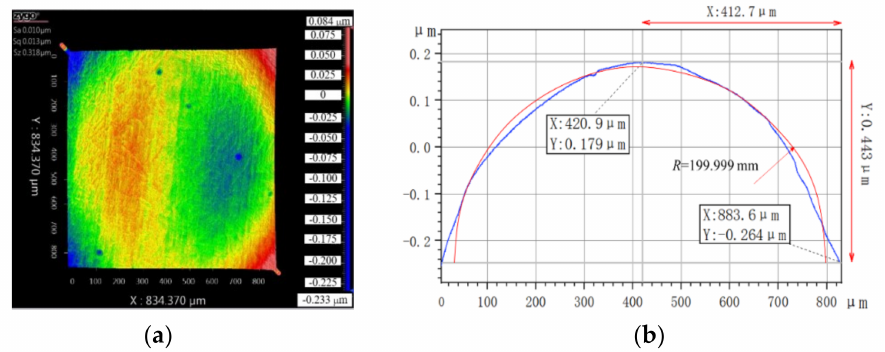
Figure 4. Surface quality and shape error of spherical datum surface characterized by white light interferometer. ( a ) Surface morphology; ( b ) Surface profile.